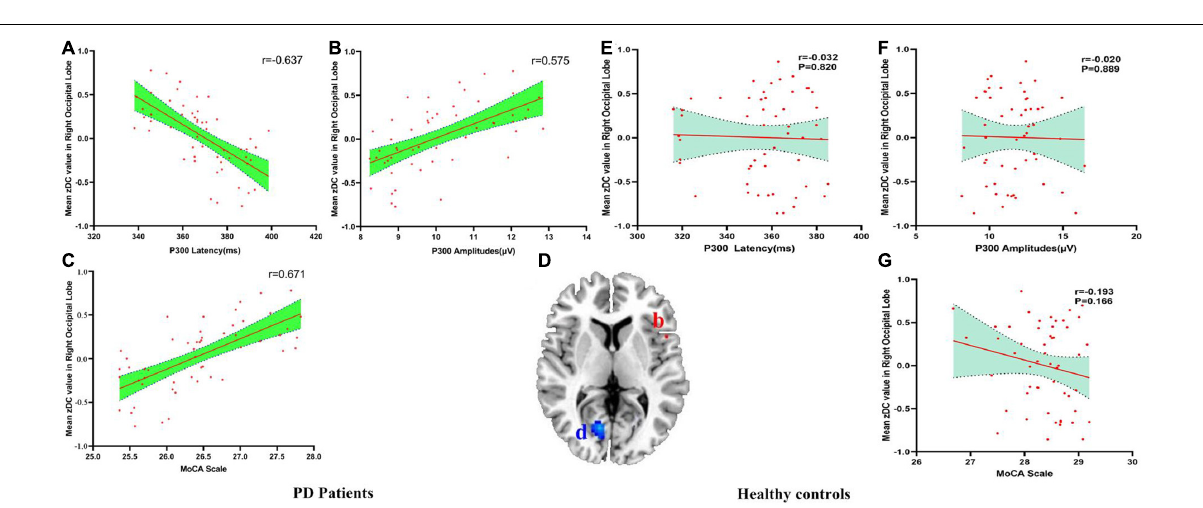
FIGURE 3 | (A–G) The correlation results between mean zDC value in right occipital lobe and P300 latency, P300 amplitudes and MoCA scale in PD patients and healthy controls. DC, Degree Centrality. The brain region in the red Alphabet b was left precentral gyrus. The brain region in the blue Alphabet d was right occipital